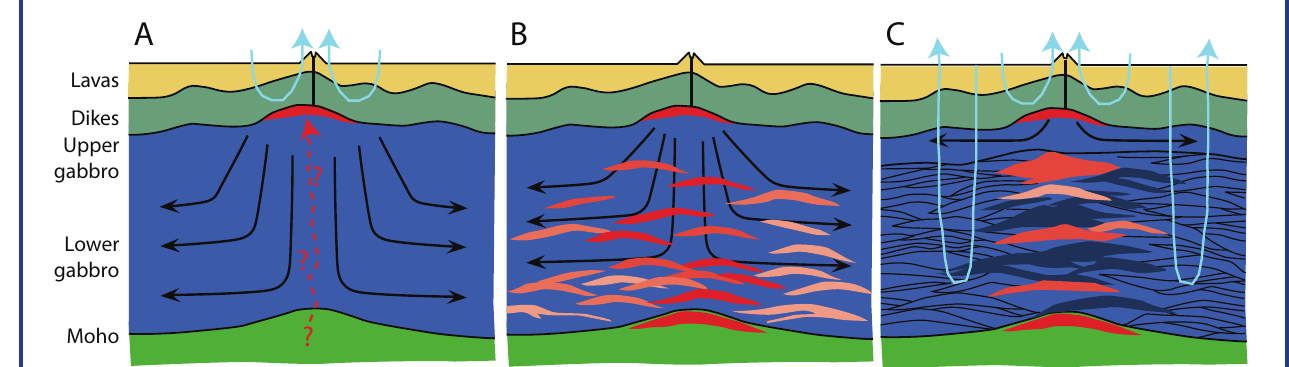
Figure 5. Diagrams of crustal accretion models (modified from Korenaga and Kelemen, 1998). Black arrows show the movement of the solid lower crust; blue arrows show the dominant zones where hydrothermal circulation will remove latent and sensible heat; red arrows show the movement of magma (unknown in all models). [A] Gabbro glacier ductile flow model (Henstock et al., 1993; Phipps Morgan and Chen, 1993; Quick and Denlinger, 1993). Ductile flow down and outward from a high level axial magma chamber constructs the lower crust. [B] A hybrid model of ductile flow with sill intrusions (Boudier et al., 1996). [C] “Sheeted” or “stacked” sill model of in situ formation of the lower crust by on-axis sill intrusions (Bédard et al., 1988; Kelemen et al., 1997; Kelemen and Aharonov, 1998; MacLeod and Yoauancq, 2000). (Original figure by Rosalind Coggon).